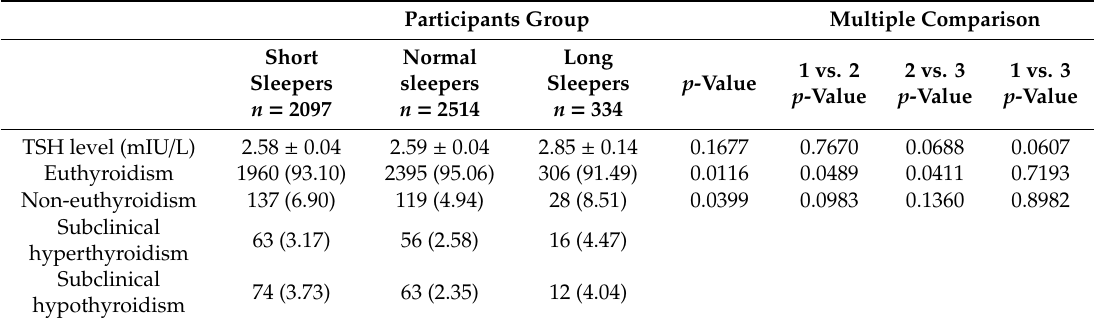
Table 2. The prevalence of subclinical thyroid dysfunctions and mean serum thyrotropin (TSH) levels according to sleep